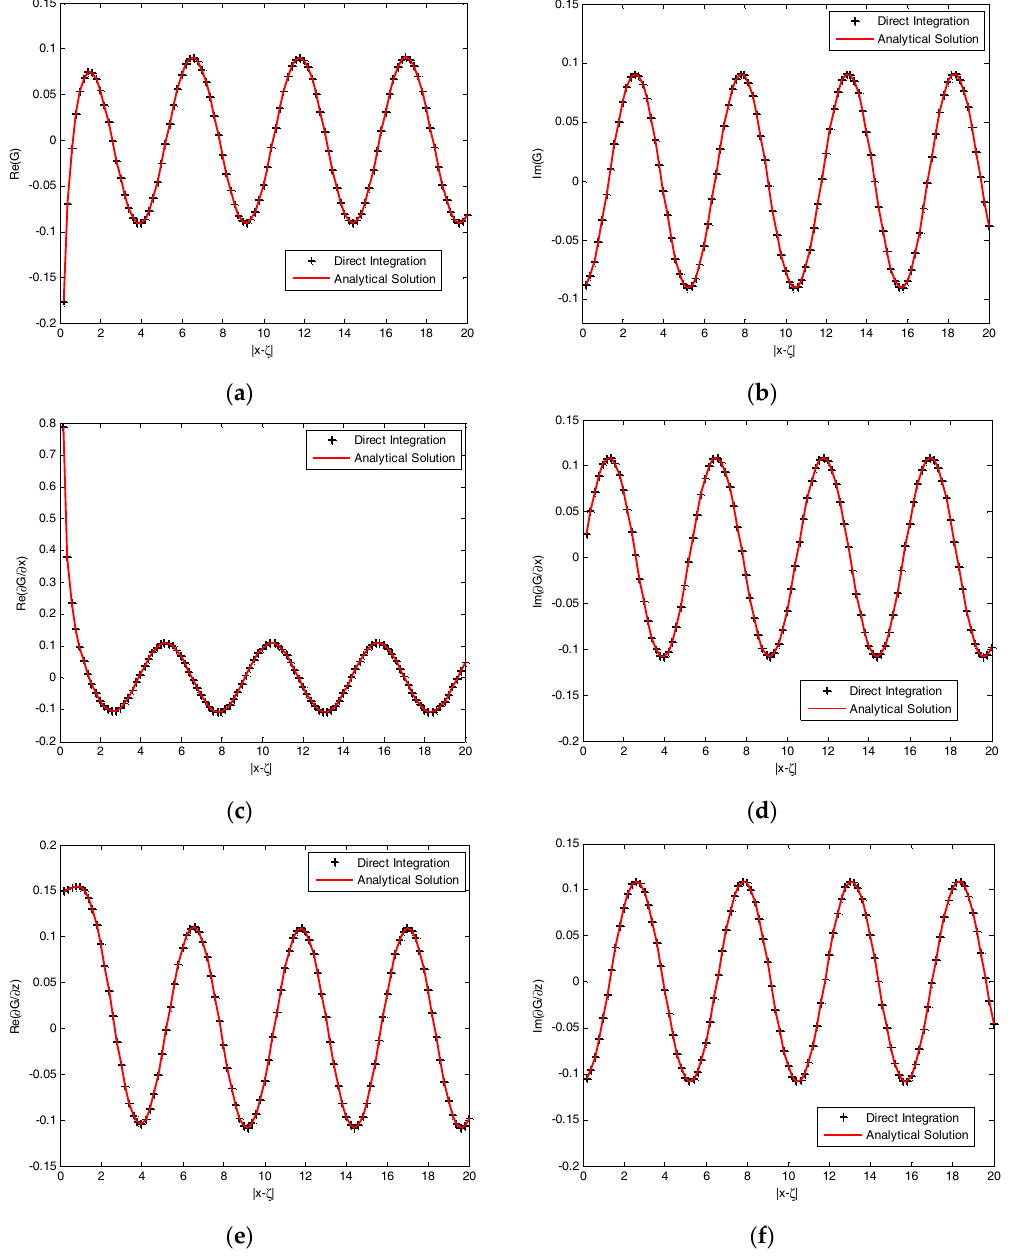
Figure 5. Comparison of two methods for calculating Wehausen’s Green function and its derivatives ( K = 1.2 m − 1 , ζ = − 1.0 m, z = − 1.0 m): ( a ) real part value of G ; ( b ) imaginary part value of G ; ( c ) real part value of G x ; ( d ) imaginary part value of G x ; ( e ) real part value of G z ; and ( f ) imaginary part value of G z .